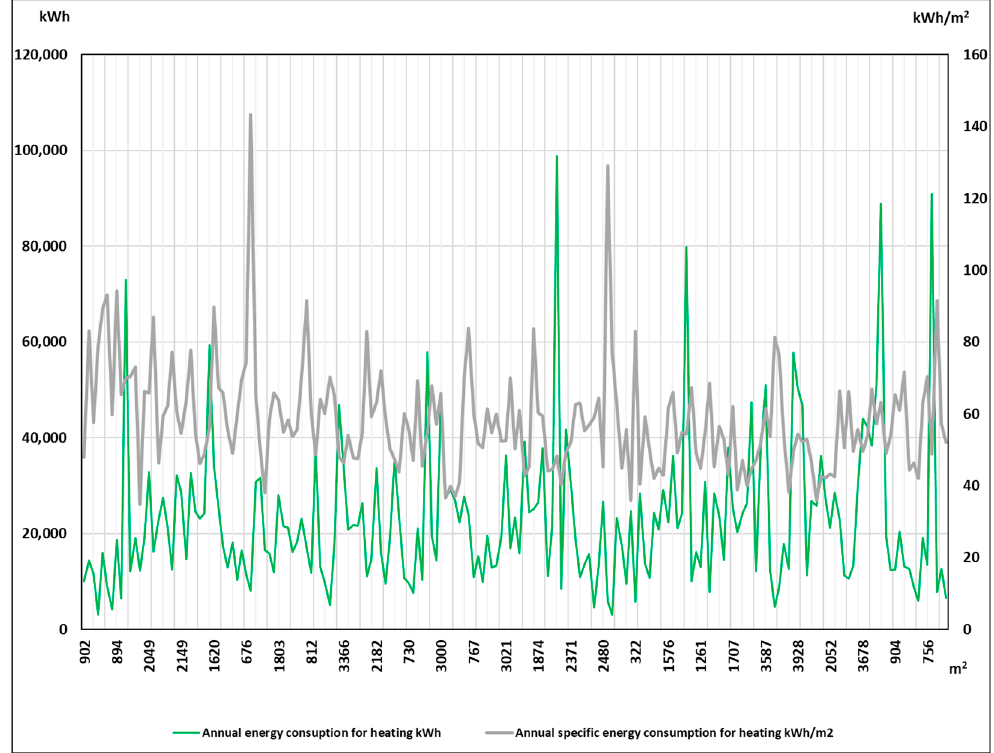
Figure 4. Average specific energy consumption for heating of residential buildings connected to the DHS for 2020.